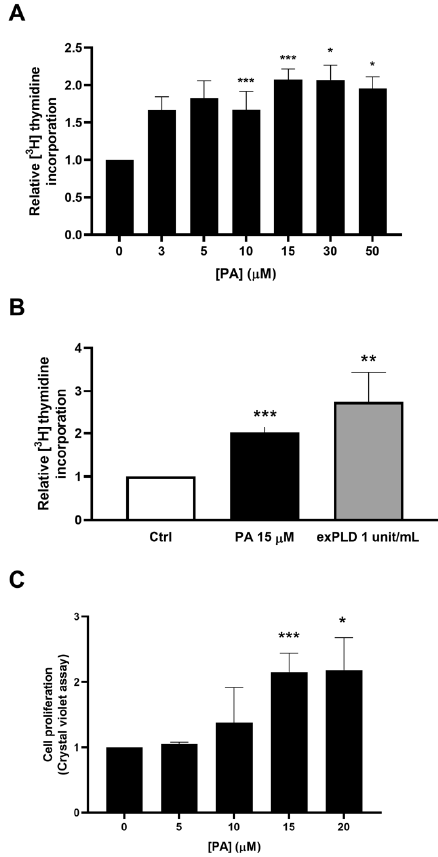
Figure 1. Phosphatidic acid (PA) stimulates C2C12 myoblast proliferation. Approximately 40% confluent C2C12 myoblasts were serum-starved for 24 h in Dulbecco’s modified eagle’s medium (DMEM) supplemented with 0.1% bovine serum albumin (BSA). A. Cells were treated for 16 h with PA at the indicated concentrations. [ 3 H]Thymidine incorporation into DNA was measured